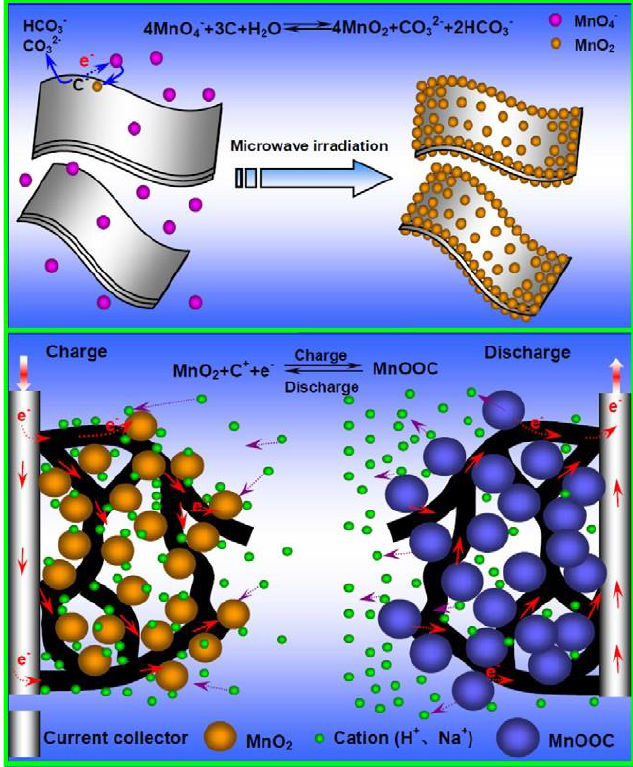
Figure 9. Schematic illustration for the synthesis and electrochemical performance of graphene – MnO 2 composite. Reproduced with permission from [5]. Copyright © 2000, Elsevier Science Ltd.